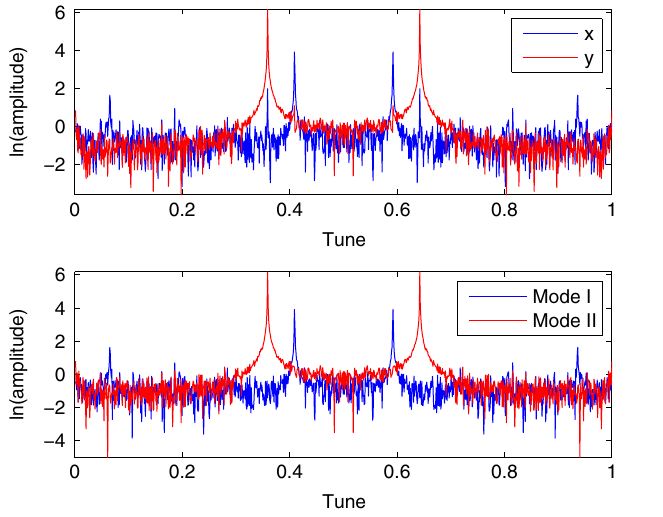
FIG. 9. Fourier spectra of beam position coordinates returned by BPM 7W over 1024 consecutive turns, with mode II resonant excitation. Note that the (fractional part of the) mode I tune is 0.59, and the (fractional part of the) mode II tune is